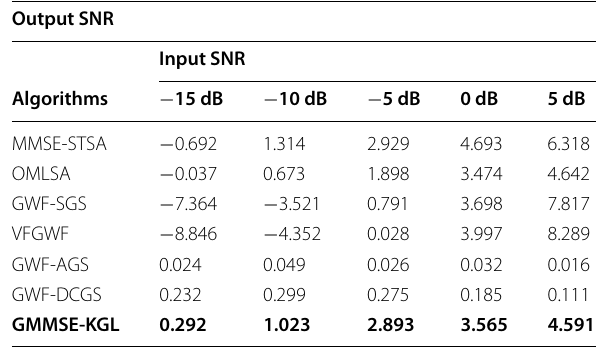
Table 7 The PESQ of different methods for Gaussian color noise PESQ